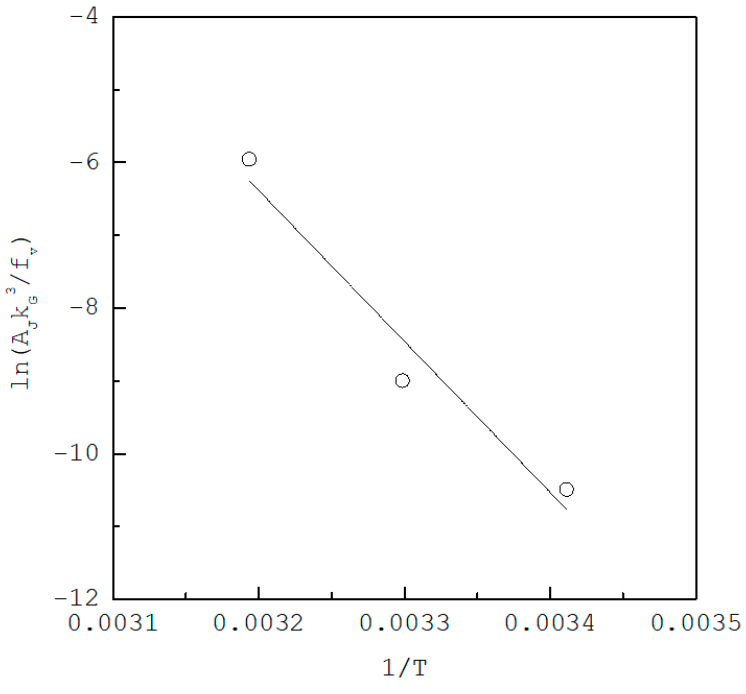
A J k G 3 (cid:3002) (cid:3259) (cid:3038) (cid:3256)(cid:3119) versus 1 versus (cid:2869) f V (cid:3033) (cid:3271)